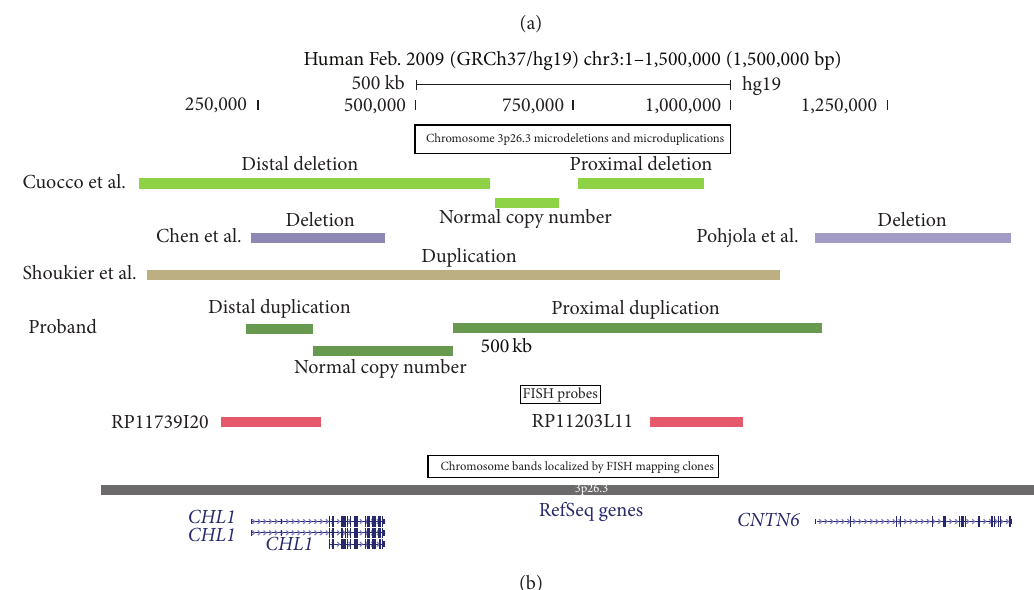
Figure 1: Schematic of chromosome 3p26.3 showing microdeletions and microduplications. (a) Shows the ideogram of chromosome 3, together with the region encompassing microdeletions and microduplications (red box). (b) Shows the location and extent of the microdeletions and microduplications detected in the proband reported here and other cases reported in the literature [6–8, 13], BAC probes used in the FISH studies, and RefSeq genes that lie within this region of chromosome 3. These graphics were taken from the UCSC genome browser